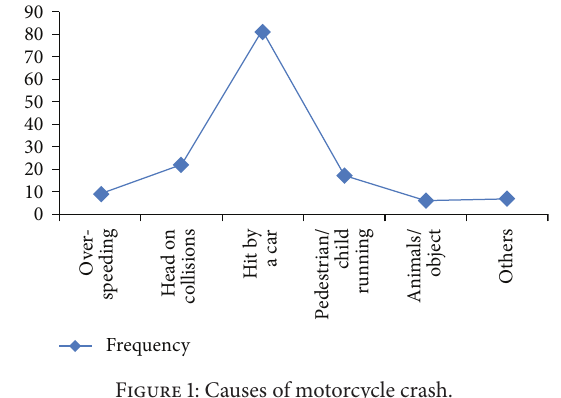
Figure 1: Causes of motorcycle crash.